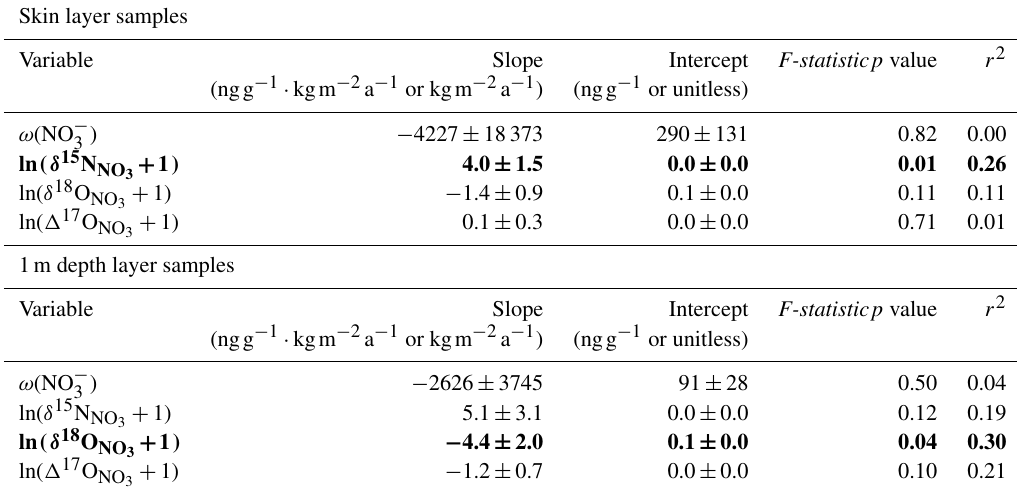
Table 2. Coefficients and statistics for the linear regressions of NO layer samples separately analyzed. Coefficient values are given with ± 1 standard error. Values of SMB used in regressions are the mean annual output of MARv3.12.1 forced with ERA5 data for the years 2011–2013 (Agosta et al., 2019; Amory et al., 2021). Regressions with statistically significant f-statistic ( p < 0.05) values are bolded.